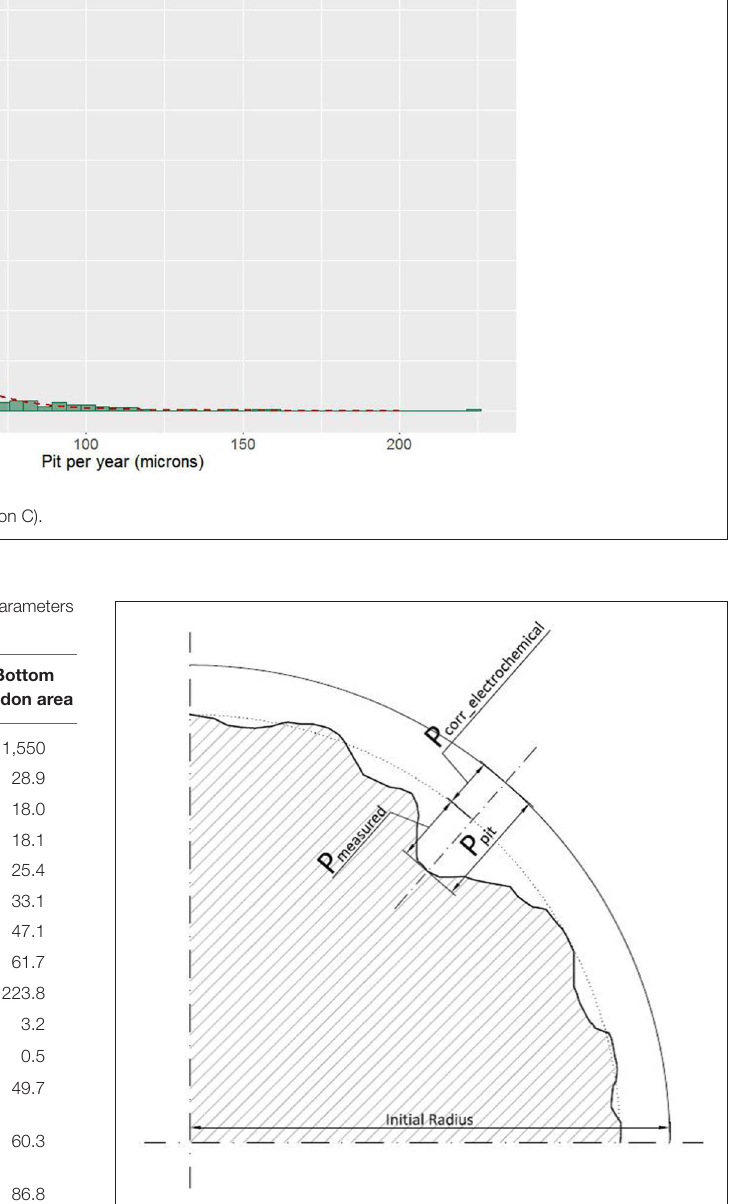
FIGURE 9 | Outline of pitting factor α